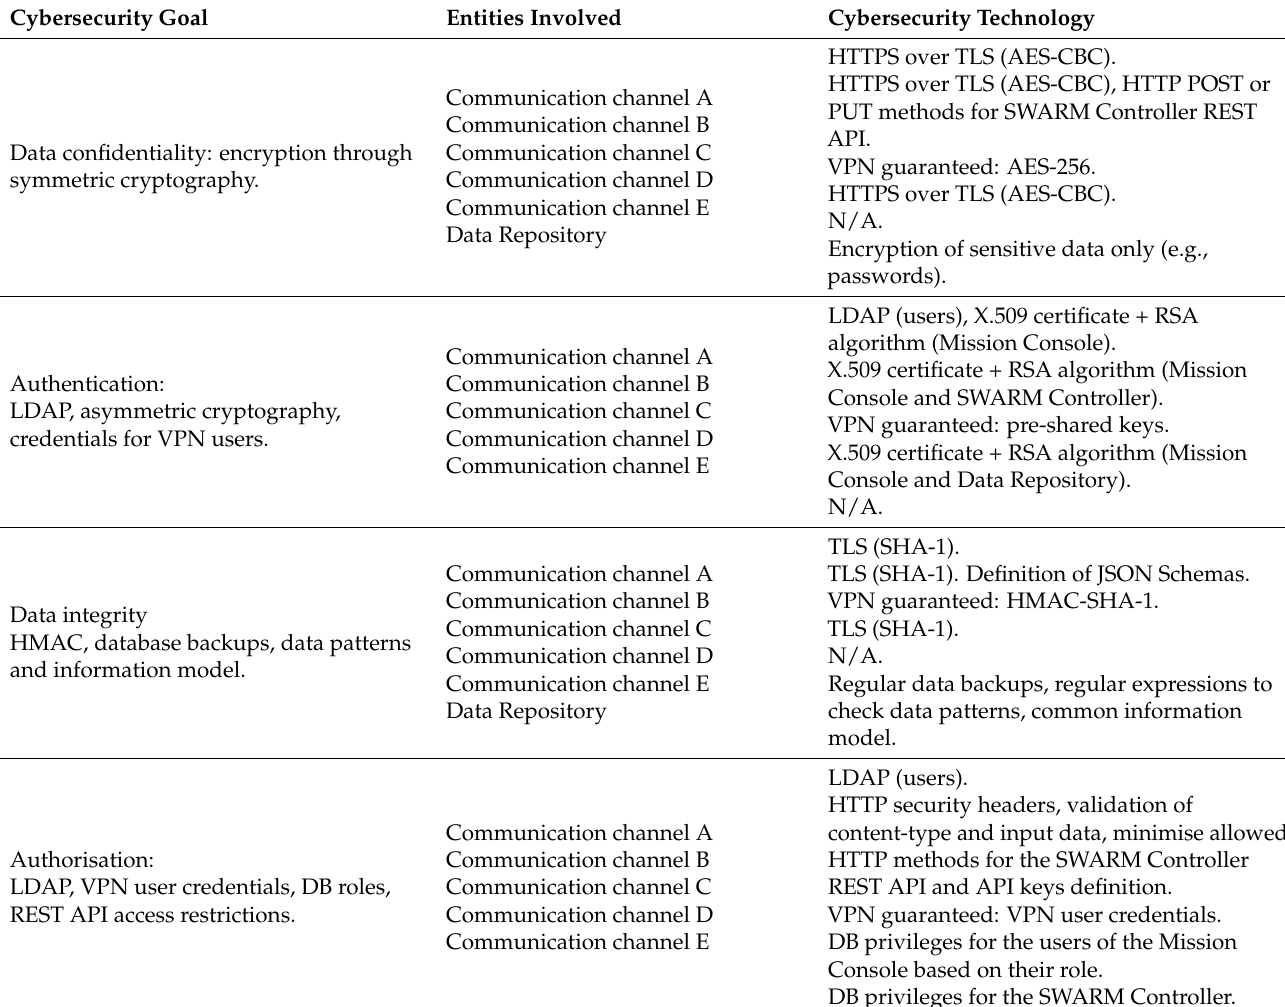
Table 2. Summary of the cybersecurity solutions proposed for the target